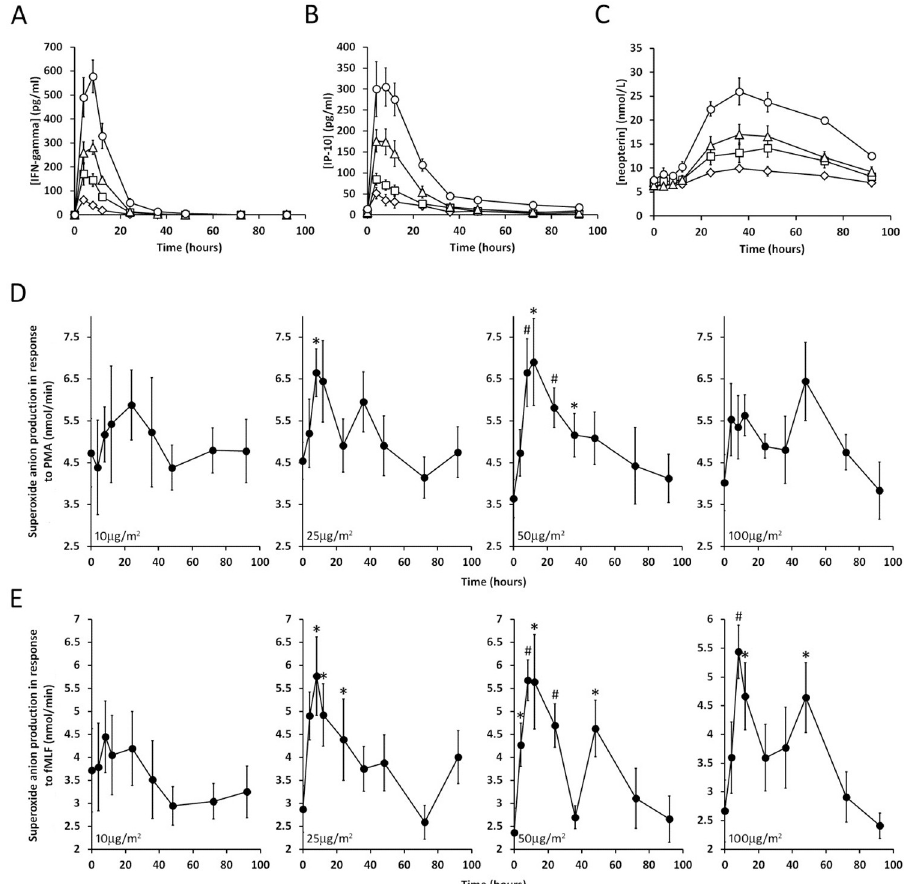
Fig 2. A, B and C: IFN- γ , IP-10 and neopterin levels (respectively) in plasma of healthy volunteers. IFN- γ was administered just after blood was taken for the time 0 time point. The responses to different concentrations are indicated by different symbols (10 μ g/m 2 , diamonds; 25 μ g/m 2 , squares; 50 μ g/m 2 , triangles and 100 μ g/m 2 , circles). The error bars are SEM for n � 7. D and E: Superoxide anion production by neutrophils. At the same time points as in A, B and C, neutrophils were isolated from the peripheral blood of healthy volunteers and superoxide anion production was stimulated by PMA (D) and fMLF (E). The error bars are SEM for n � 7. The asterisks and pound signs indicate differences (p = 0.008–0.043 and p = 0.001–0.004 respectively) from time 0 (two tailed